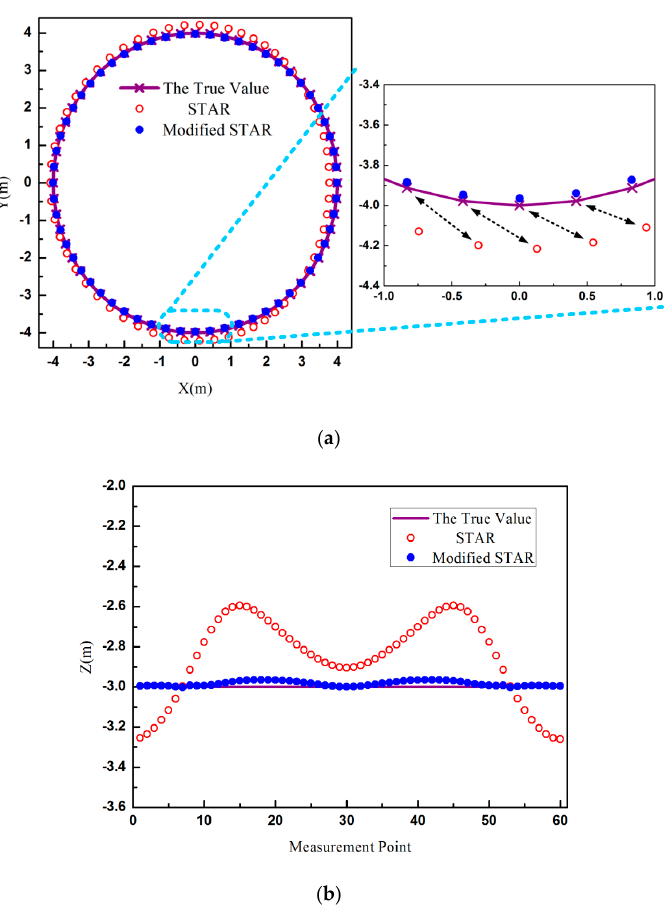
Figure 2. The estimated positions of two methods. ( a ) The estimated positions on the XY plane; ( b ) The estimated positions on the Z-axis.